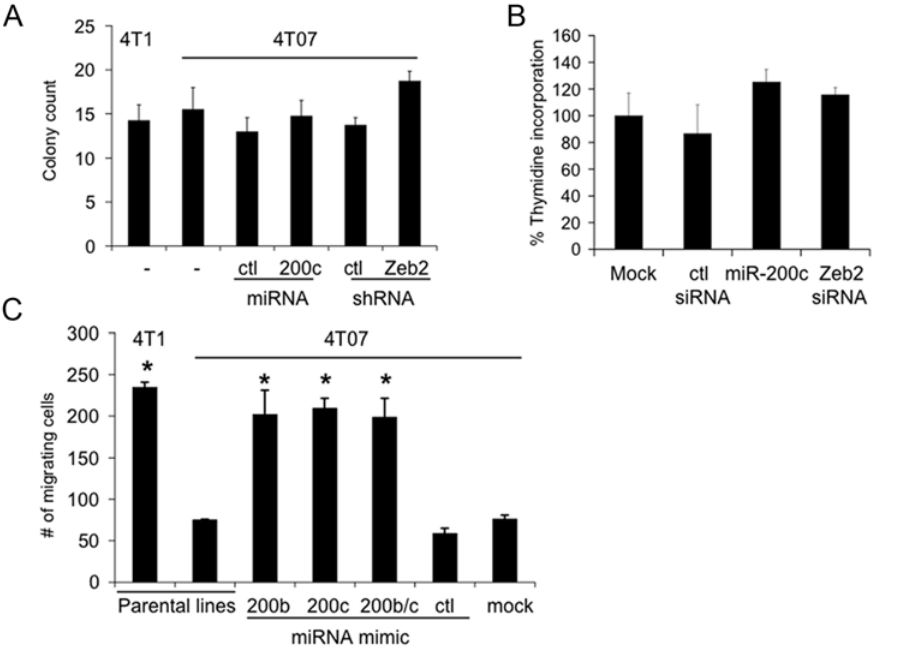
Figure 6. miR-200 enhances 4TO7 cells migration through a basement membrane, but does not affect cell proliferation. (A) Exogenous expression of the miR-141-200c cluster (compared to the control vector expressing luciferase shRNA) or Zeb2 shRNA (compared to a luciferase shRNA construct) in 4TO7 cells does not alter colony growth in soft agar. Parental 4TO7 and 4T1 cells also are equally efficient at forming colonies. (B) Cell proliferation as measured by thymidine incorporation is also unaffected in 4TO7 cells expressing miR-200c mimic or Zeb2 siRNA. The mean and standard deviation of 6 independent experiments is shown. (C) Transient over-expression of miR-200b and/or miR-200c enhances the migration of the 4TO7 cells through a basement membrane to the same level as the highly invasive 4T1 cells. The mean and standard deviation from analyzing five fields from triplicate samples is shown (*, p , 0.01, compared to untreated (parental) 4TO7 cells).